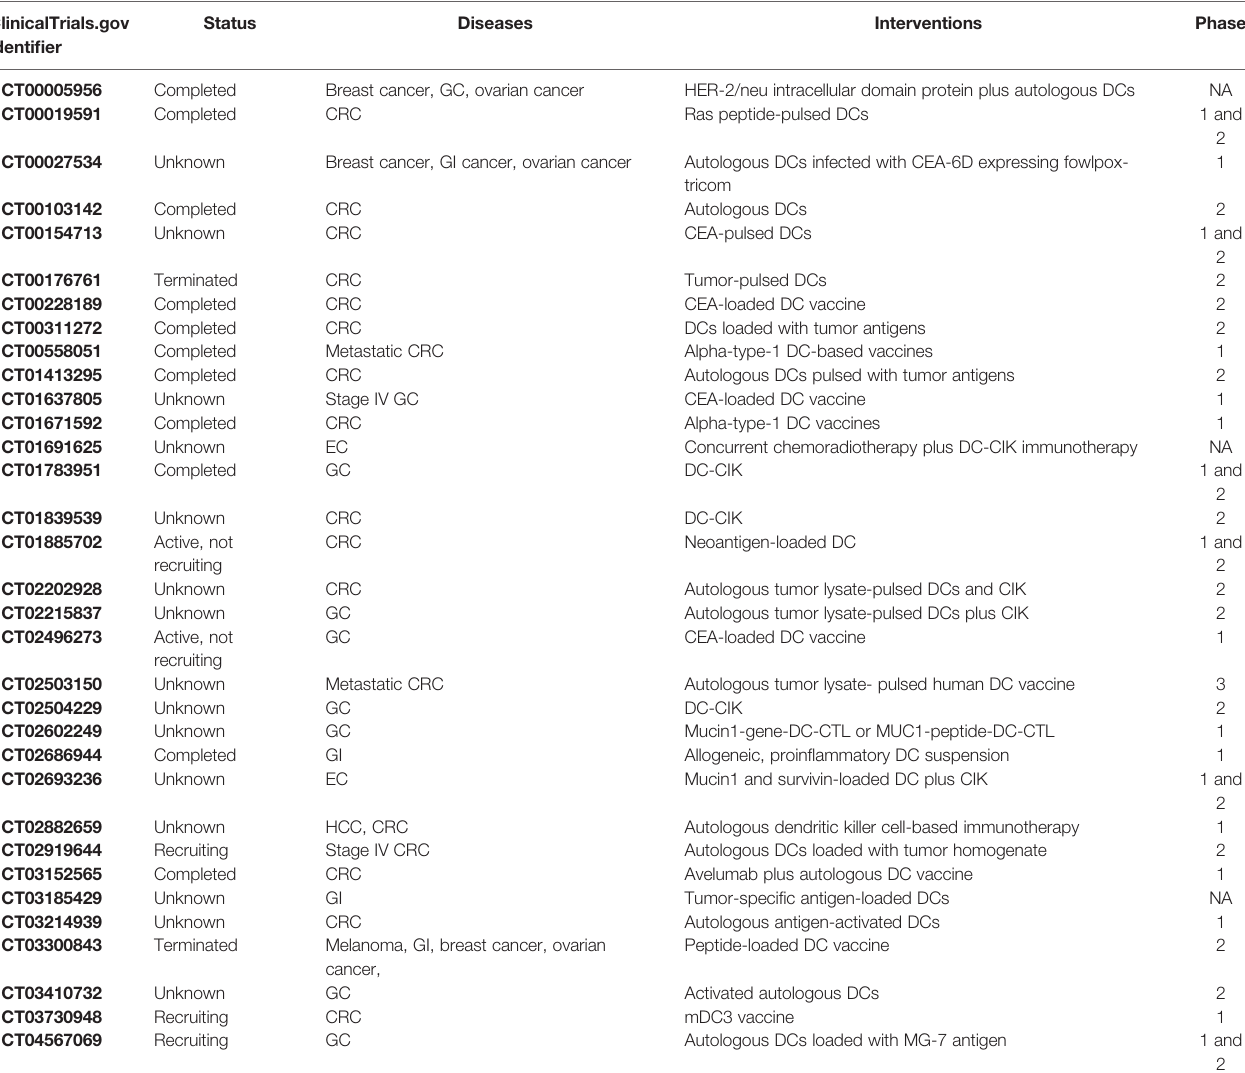
TABLE 2 | Summary of clinical trials of DC-based therapy. ClinicalTrials.gov Identi fi